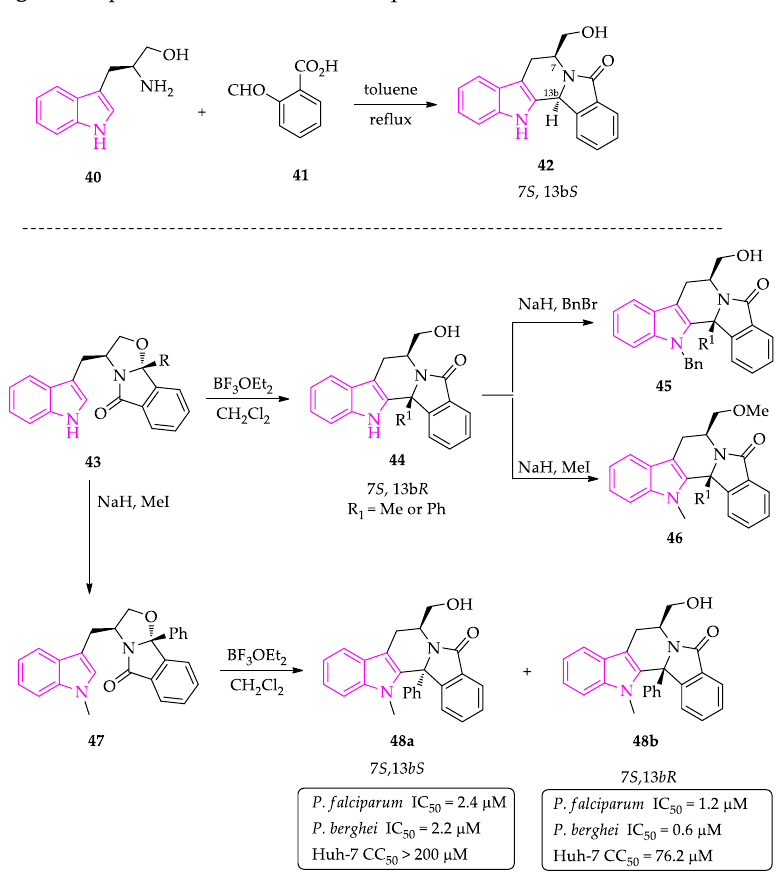
Scheme 1. Synthesis of